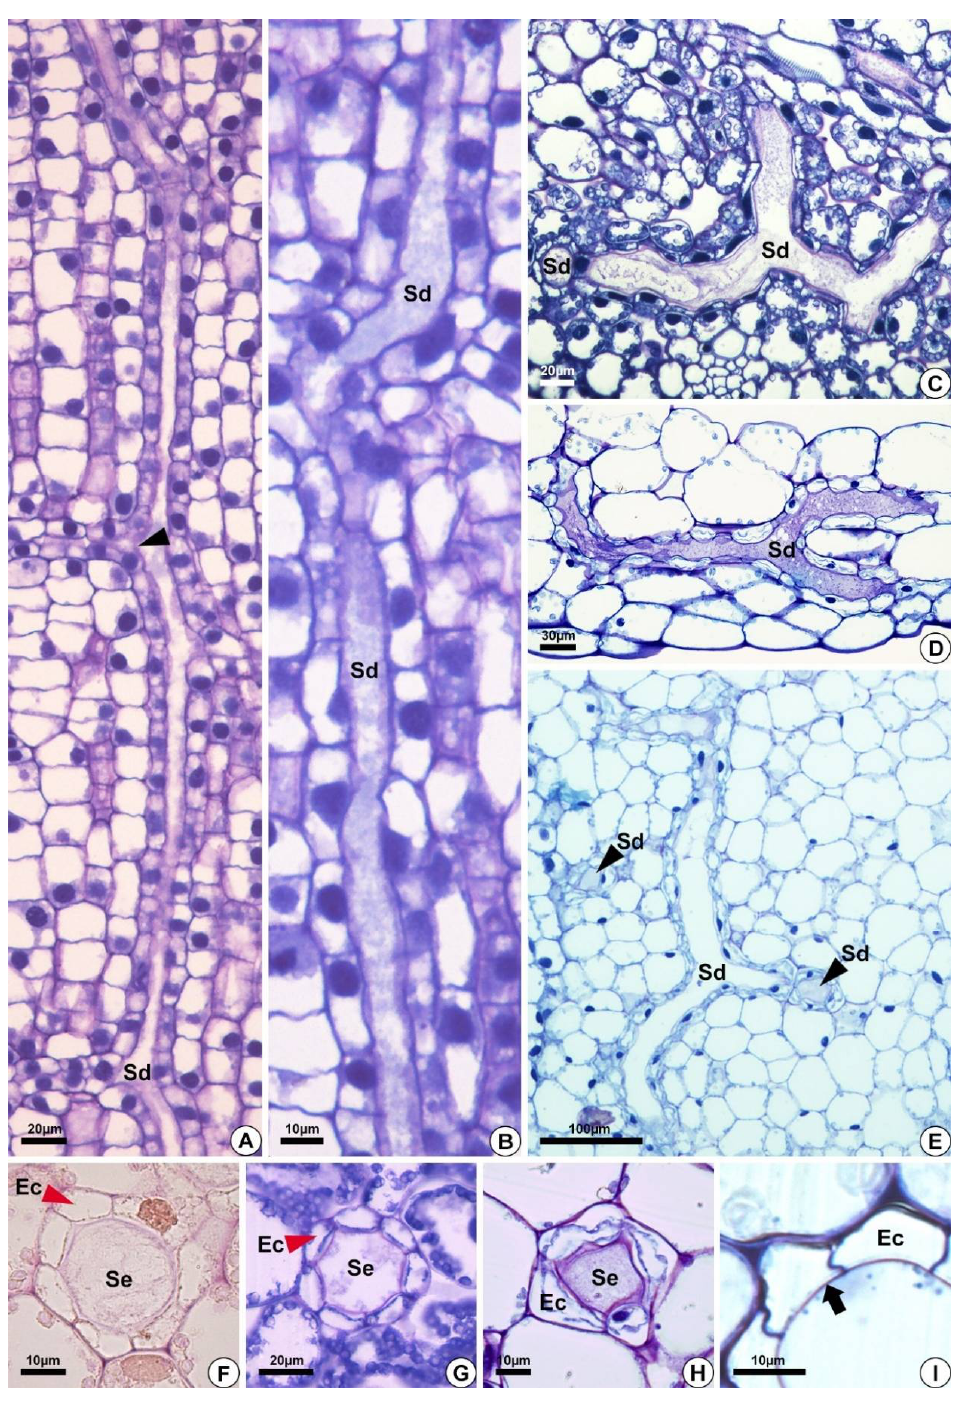
Figure 3. Structure of the secretory ducts of Hydrocleys nymphoides ( A , B ), Sagittaria rhombifolia ( C , F , G ), Limnocharis flava ( D , E , H ), and Echinodorus grandiflorus ( I ). ( A – E ) Longitudinal sections. ( F – I ) Cross-sections showing secretory ducts in the aerenchyma tissue of the petiole. All preparations were stained with toluidine blue, except for the one shown in ( F ), which was stained with Schiff reagent (PAS). ( A ) Secretory ducts with anastomoses in different directions (black arrowhead). ( B ) Elongated secretory ducts. ( C – E) Anastomosing secretory ducts “Y”-shaped. ( D ) Epithelial cells surrounding the lumen. ( E ) Secretory ducts in longitudinal (Sd) and cross-sections (black arrowheads–Sd). ( F – H ) Cross-section showing secretory ducts with a layer of epithelium (red arrowheads) composed of variable epithelial cell numbers. ( I ) Pectocellulosic cell wall of epithelial cells (arrows). Sd = secretory ducts. Ec = epithelial cells. Se = secretion.